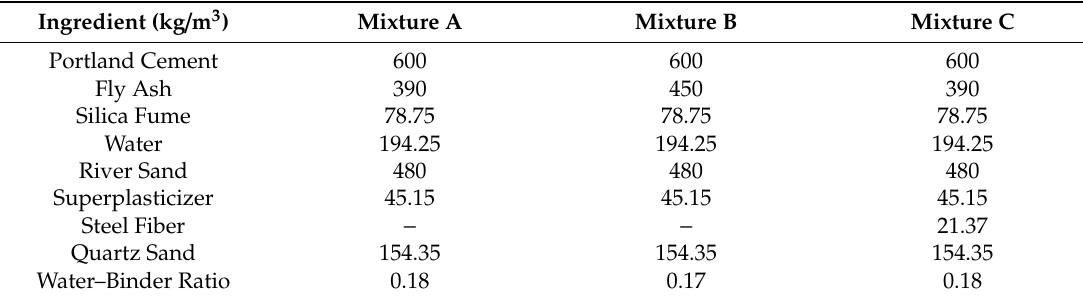
Table 2. Trial mix of high-performance composite concrete.